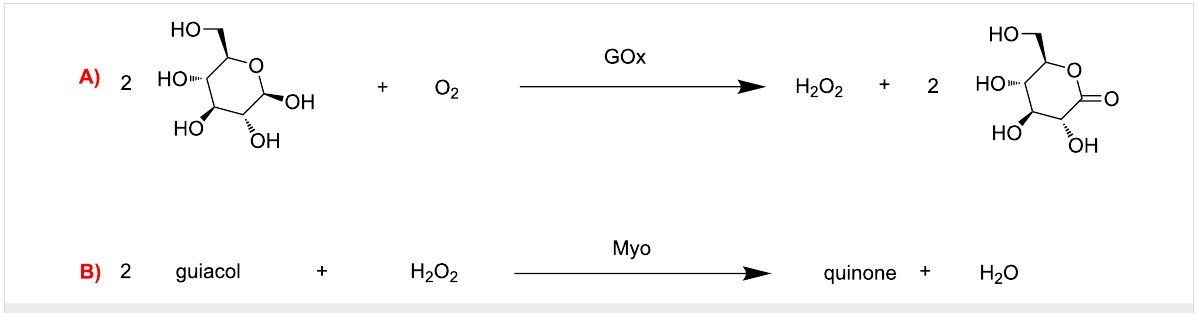
hydrophobic membrane and as a consequence a higher reaction